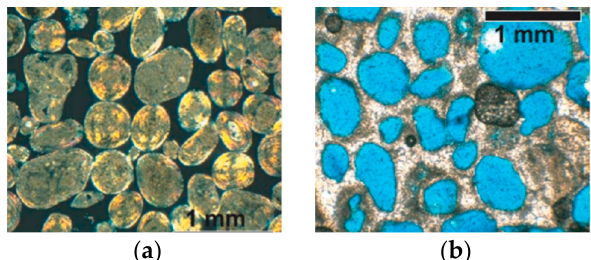
Figure 22. Curves showing that the ratio of surface area (vertical scale) to volume (horizontal scale) is smallest for pore spaces closer to spherical shapes and largest for pyramidal pore shapes. For any particular finite volume of fluid, the surface contact area with the pore wall varies with pore shape and in a non-linear fashion when pore volume increases.